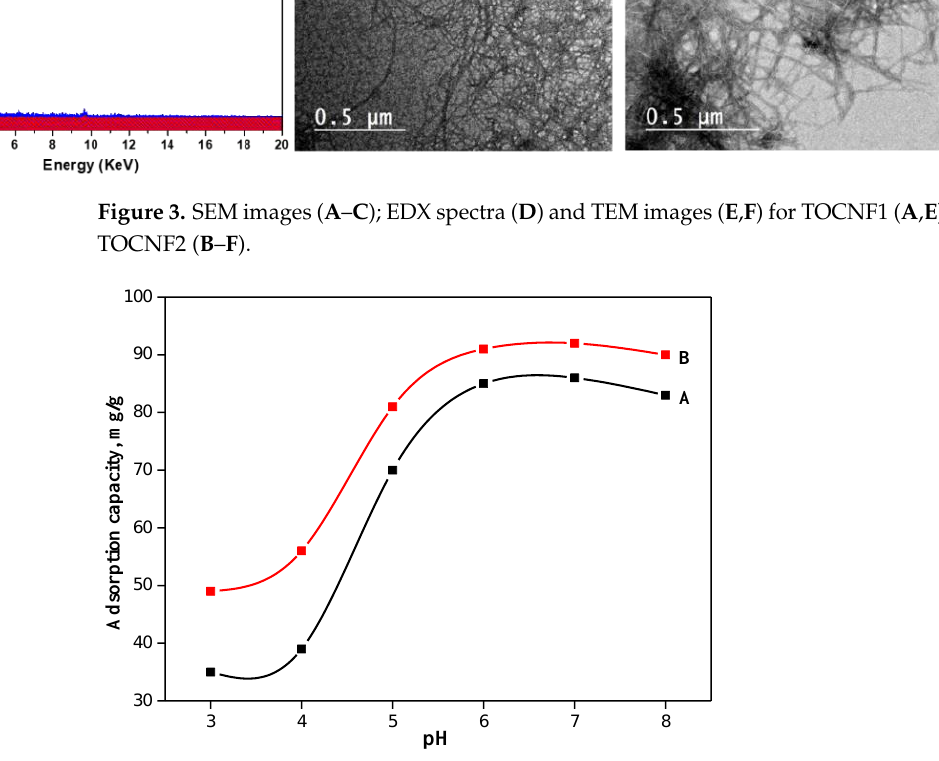
Figure 4. Effect of pH on the adsorption capacities of TOCNF1 (A) and TOCNF2 (B) towards MB (MB concentration: 100 mg/L; functionalized cellulose: 0.05 g/50 mL and contact time: 40 min).